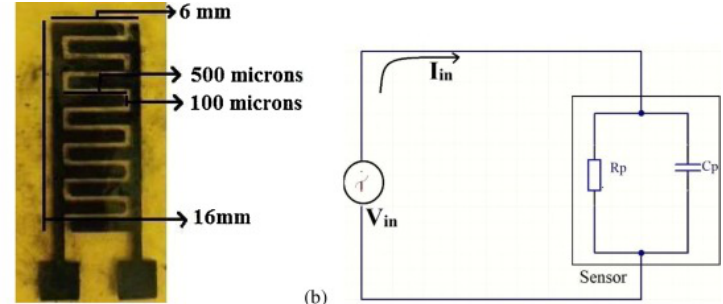
Figure 8. ( a ) Picture of the fabricated device. ( b ). The equivalent circuit of the device. Reprinted with permission from Ref.